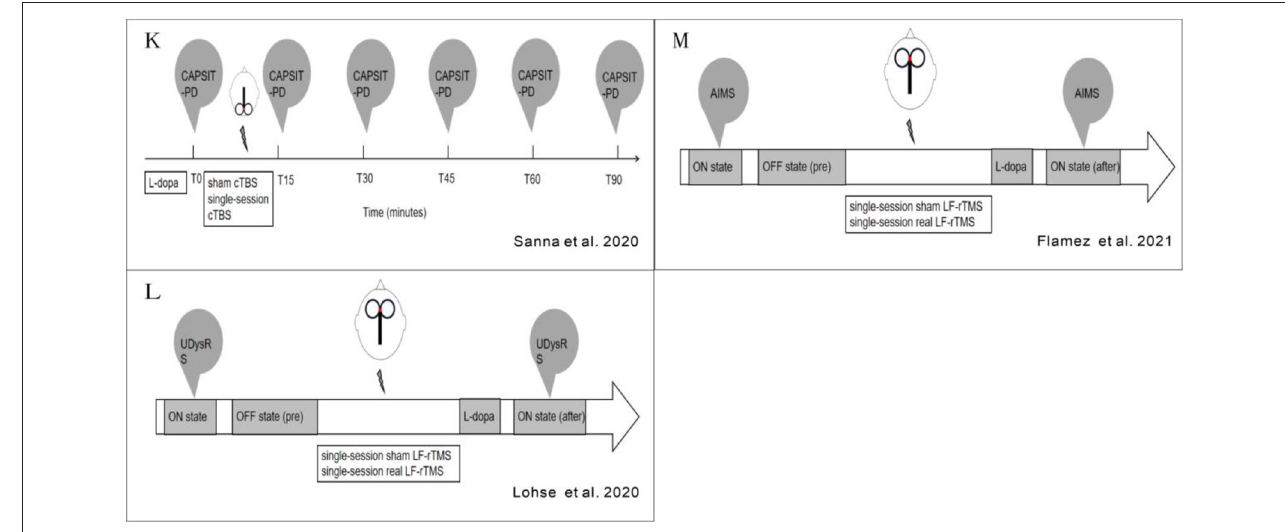
FIGURE 2 | (A–L) Refers to overview of stimulation workflow in studies mentioned in Table 1 .